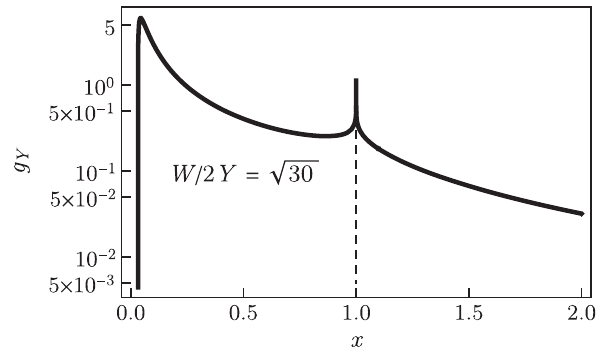
x Þ of the random variable FIG. 16. Plot of the PDF g Y ð x ¼ fð wY 2 Þ = ½ð z − ϵ Þ 2 þ Y 2 (cid:2)g , where random variables ϵ and w ϵ =W Þ and g obey distributions W − 1 p ffiffiffiffiffi ∞ ð w Þ , respectively, and A ð p 30 W= ð 2 Y Þ ¼ x Þ is given in . A detailed discussion of g Y ð Appendix L [see Eq. (L7)]. Its maximum is located at x ∼ ð Y=W Þ 2 . The singularity at x ¼ 1 corresponds to ϵ ¼ z . For large values of x ≫ 1 , the conditional PDF of f Y 2 = ½ð z − ϵ Þ 2 þ X 2 (cid:2)g is narrowly peaked around its mean value π Y=W with j ϵ − z j ∼ Y , giving rise to the relation in Eq.